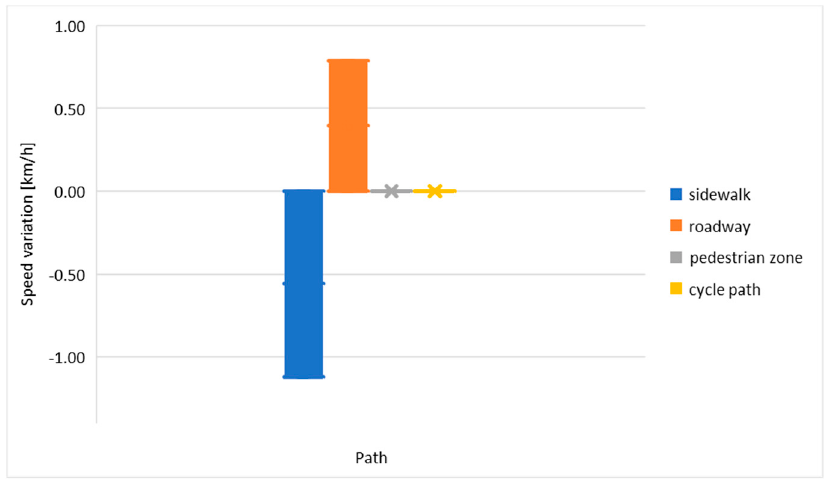
Figure 6. Differences of the absolute value of the speed with reference to path. Table 9. The test of model effects with statistical significative variables. B Std. Error Sig.